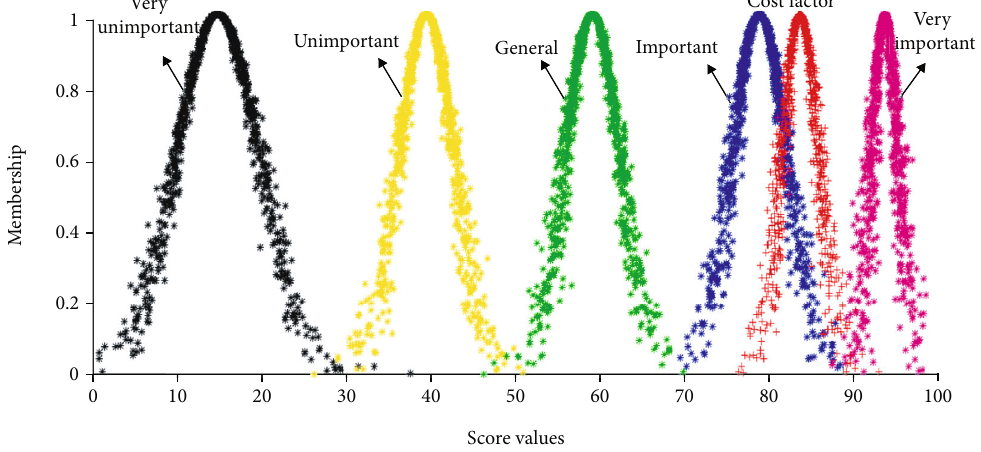
Figure 6: The comprehensive evaluation of cost factor.